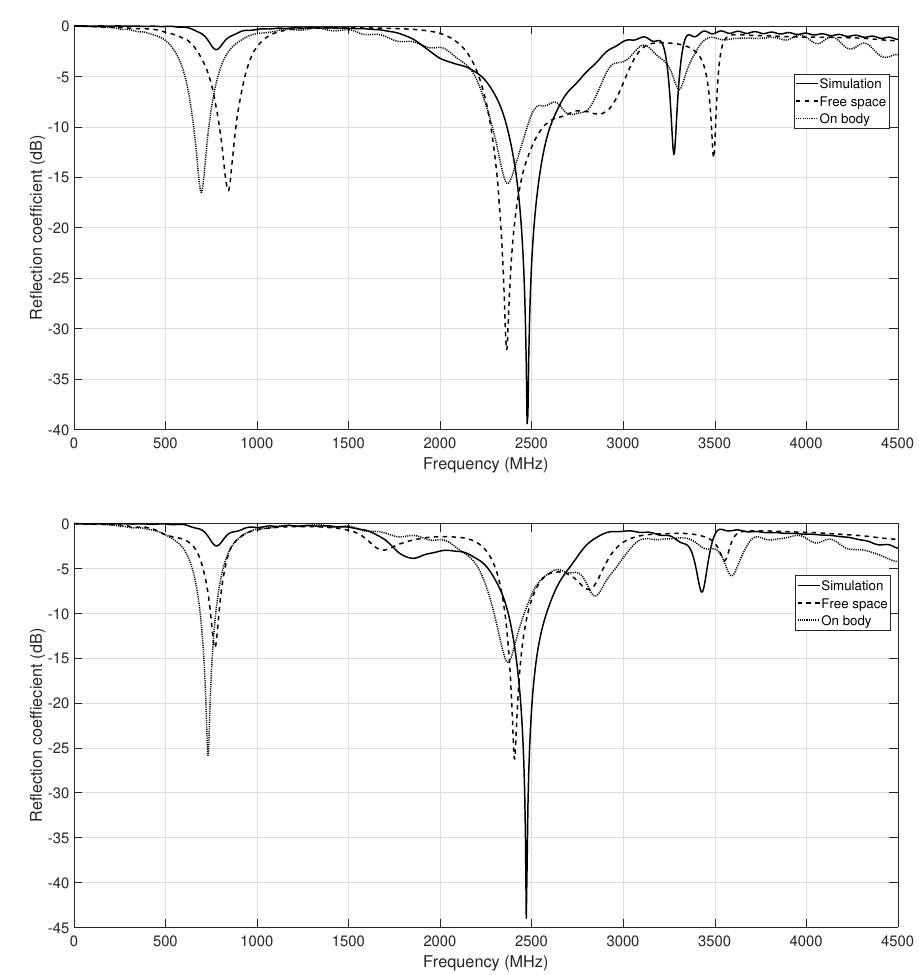
Figure 9. Reflection coefficient simulated and measured for prototypes obtained with the CRO-4SL and CRO-5SL: ( Top ) CRO-4SL prototype; ( Down ) CRO-5SL prototype.